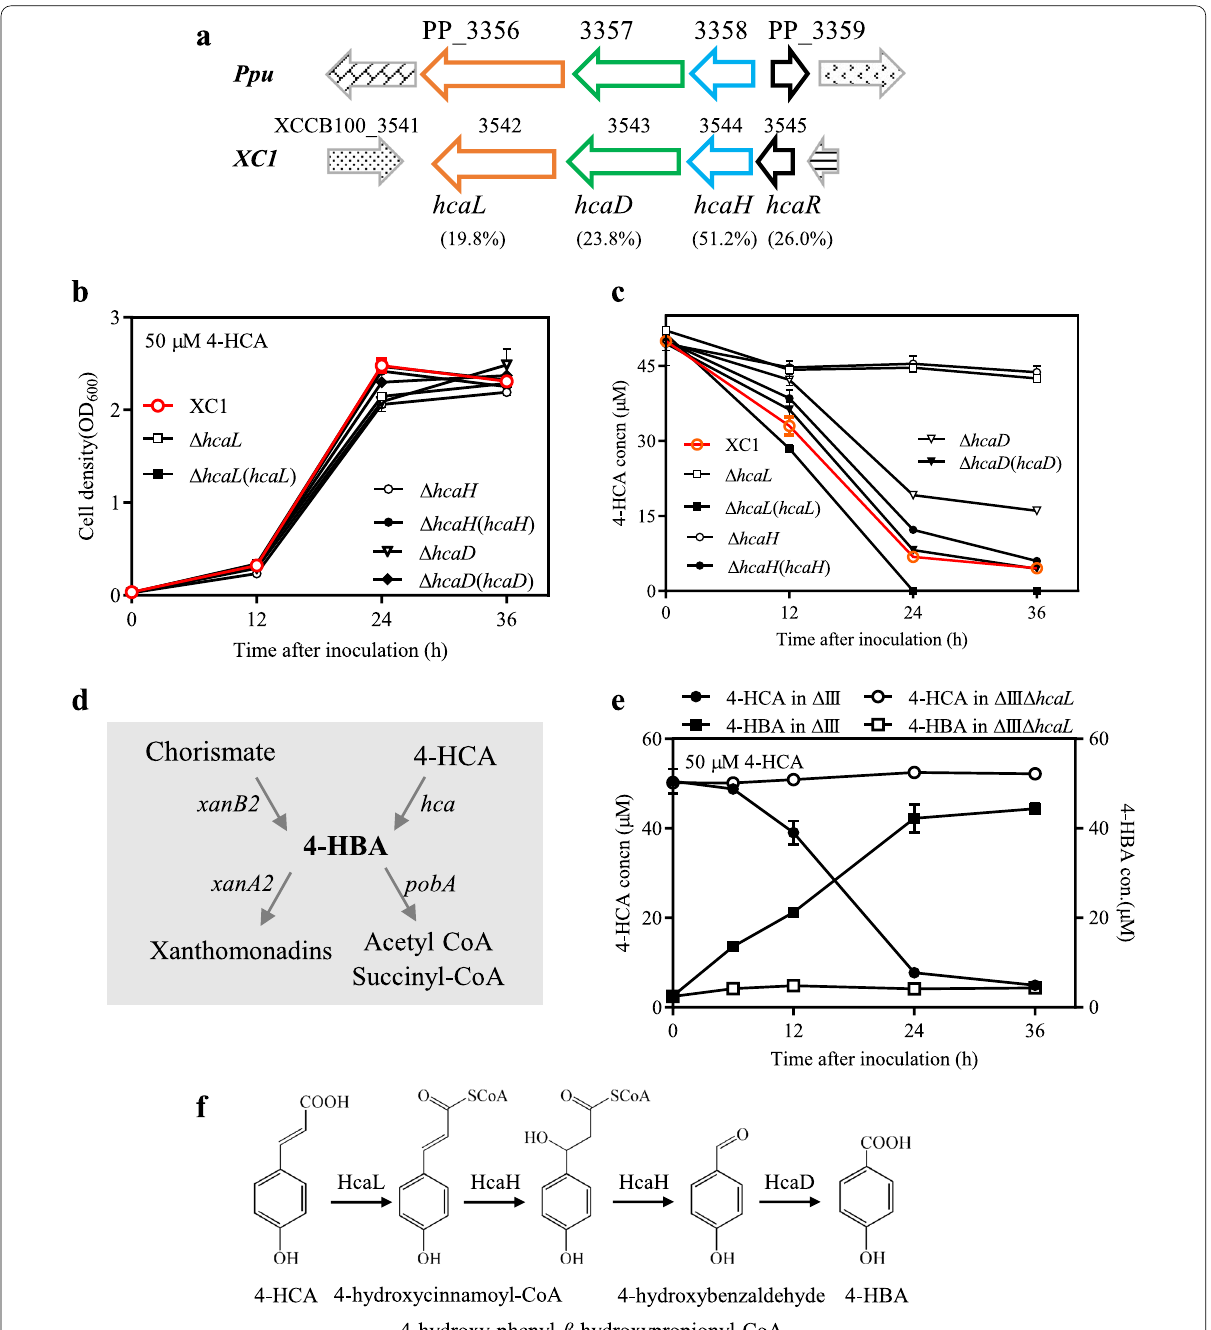
Fig. 2 4‑HCA degradation in strain XC1 of Xcc via the hca gene cluster. a Using the gene cluster PP_3356–PP_3359 which is involved in 4‑HCA degradation in Pseudomonas putida, homology analysis identified a putative 4‑HCA degradation gene cluster, hca in Xcc (colored arrows). hcaL encodes a putative 4‑hydroxycinnamoyl‑CoA ligase; hcaD encodes a benzaldehyde dehydrogenase; hcaH encodes a 4‑hydroxycinnamoyl‑CoA hydratase/lyase, and hcaR encodes a MarR‑family transcriptional regulator. The numbers inside the parentheses indicate the amino acid identity. b Growth time course of XC1 and XC1‑derived mutants in NYG medium supplemented with 50 μM 4‑HCA. c Time course for 4‑HCA production by strain XC1, XC1‑derived mutants and restored mutants in NYG cultures supplemented with 50 μM 4‑HCA. d A simple schematic diagram of 4‑HBA synthesis, utilization and degradation processes in Xcc . e Time course of 4‑HCA and 4‑HBA production of strains Δ xanB2 Δ xanA2 Δ pobA (ΔIII) and Δ xanB2 Δ xanA2 Δ pobA Δ hcaL (ΔIIIΔ hcaL ). f The proposed 4‑HCA degradation pathway in Xcc. For the data in ( b , c and e ), three